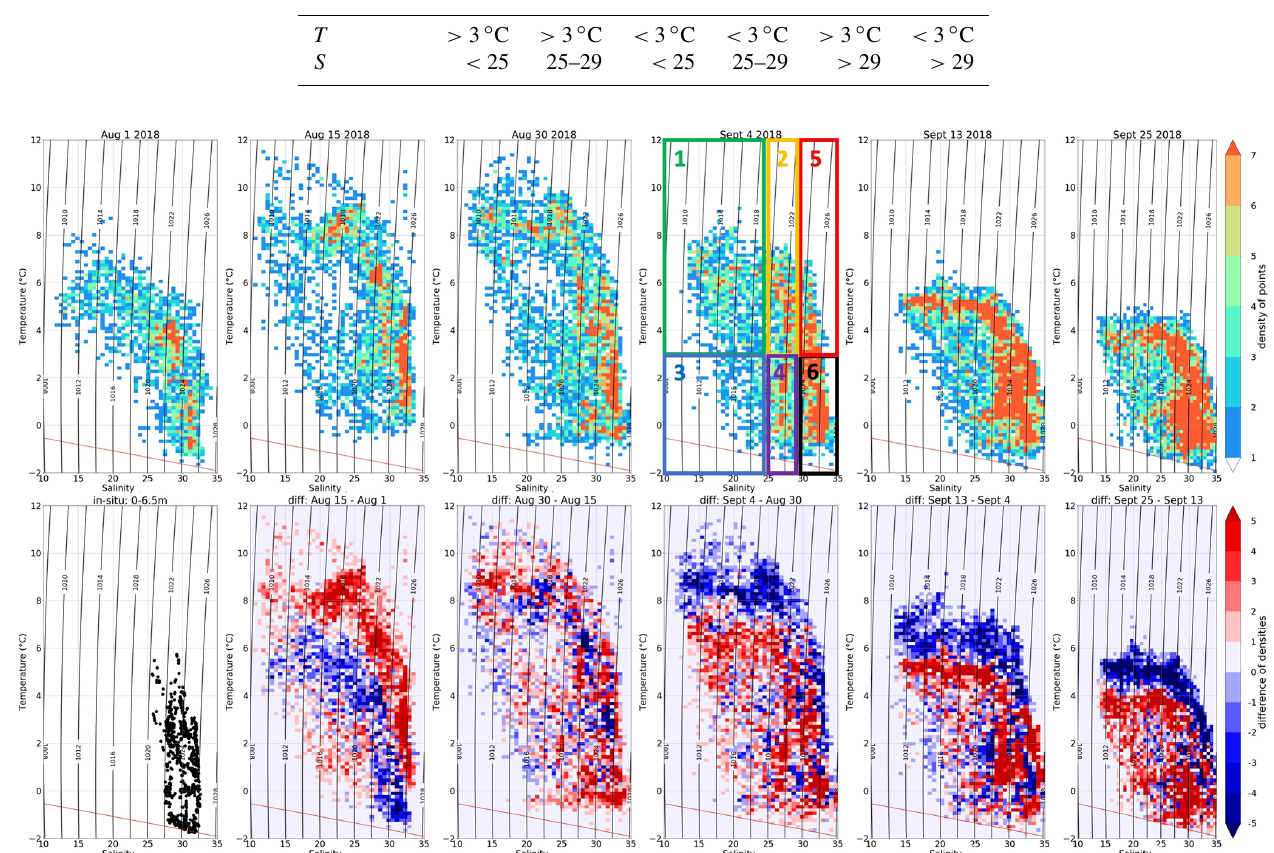
Figure 8. Temporal evolution of surface water masses in August–September 2018 for the following reference days (upper row): 1, 15, 30 August, 4, 13, and 30 September 2018. color represents the density of points (number of observations with this temperature and salinity). The red line shows the freezing point temperature for different salinity. The boxes show the cores of six water masses described in text: 1 – WF, 2 – WMS, 3 – CF, 4 – CMS, 5 – WS, and 6 – CS. The lower row shows the T – S diagram based on CTD measurements in the upper 6.5m only in column 1, and from column 2 to 6 the differences (in density points) between the reference days are shown.